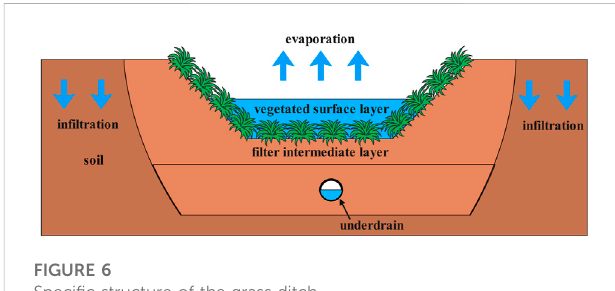
FIGURE 6 Speci fi c structure of the grass ditch.